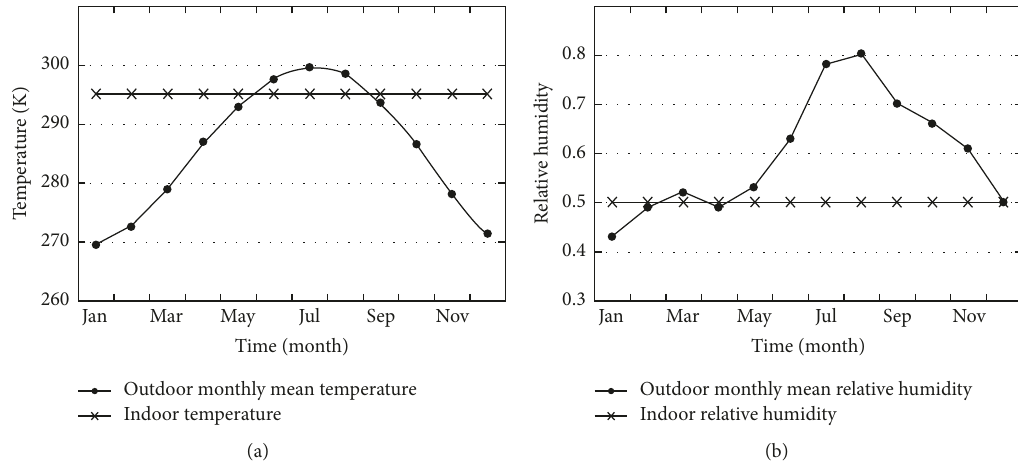
Figure 4: Ten years’ monthly mean temperature outdoor with a constant indoor temperature of 295K in Beijing (a), and ten years’ relative humidity outdoor with 50% relative humidity indoor in Beijing (b).